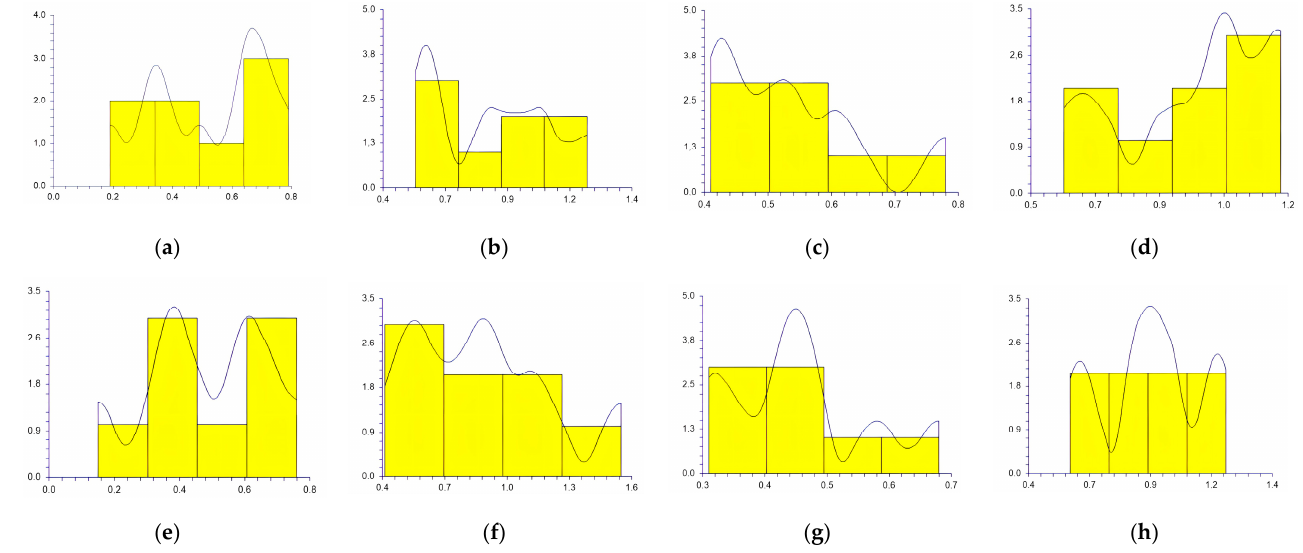
Figure 6. The chamfer width obtained at the reference points by all the participants Thursday: ( a ) t1 sitting position; ( b ) t2 sitting position; ( c ) T1 sitting position; ( d ) T2 sitting position; ( e ) t1 supine position; ( f ) t2 supine position; ( g ) T1 supine position; ( h ) and T2 supine position.